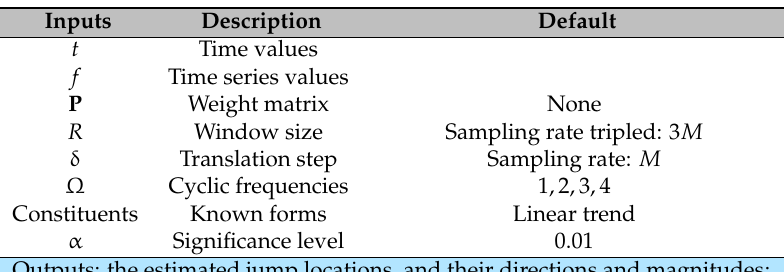
Table 1. Main inputs and outputs of